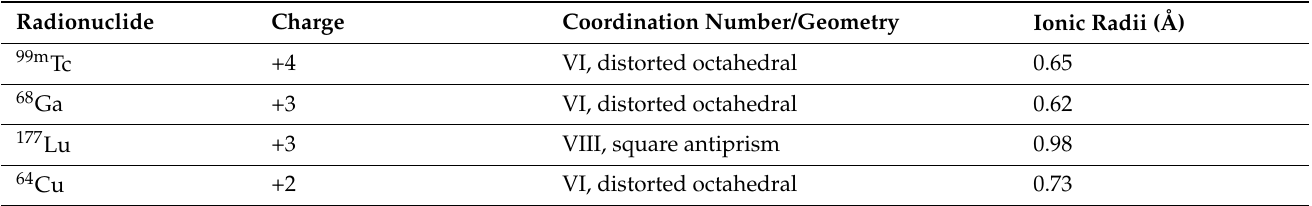
Table 5. Coordination features of the radionuclides. Adapted from Price and Orvig [31]. Radionuclide Charge Coordination Number/Geometry Ionic Radii (Å) VI, distorted